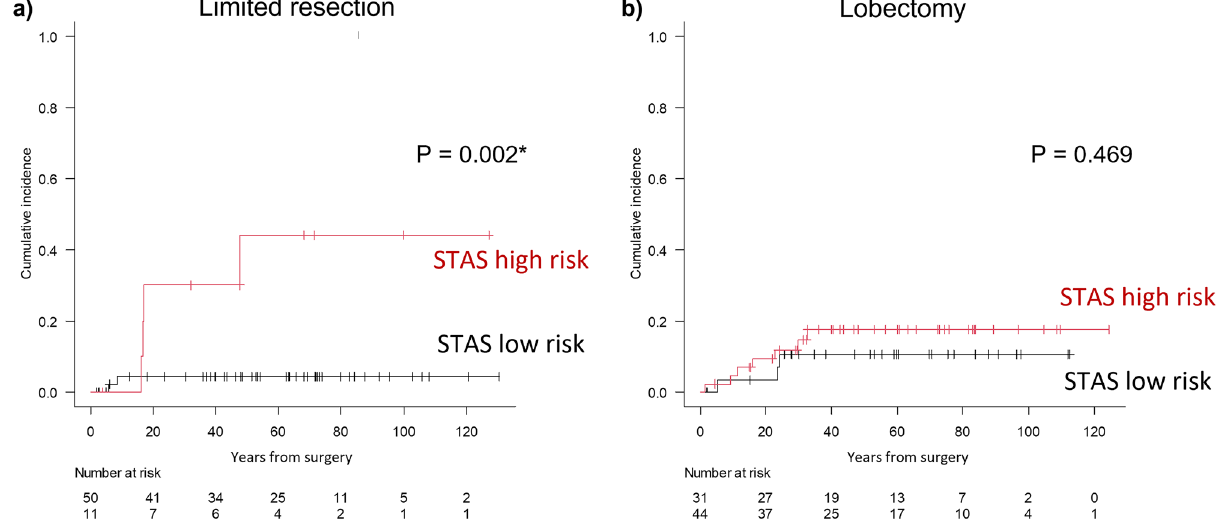
Figure 6. Cumulative incidence of recurrence by the cutoff value of peritumoral radiomics model in the limited resection group ( a ) and the lobectomy group ( b